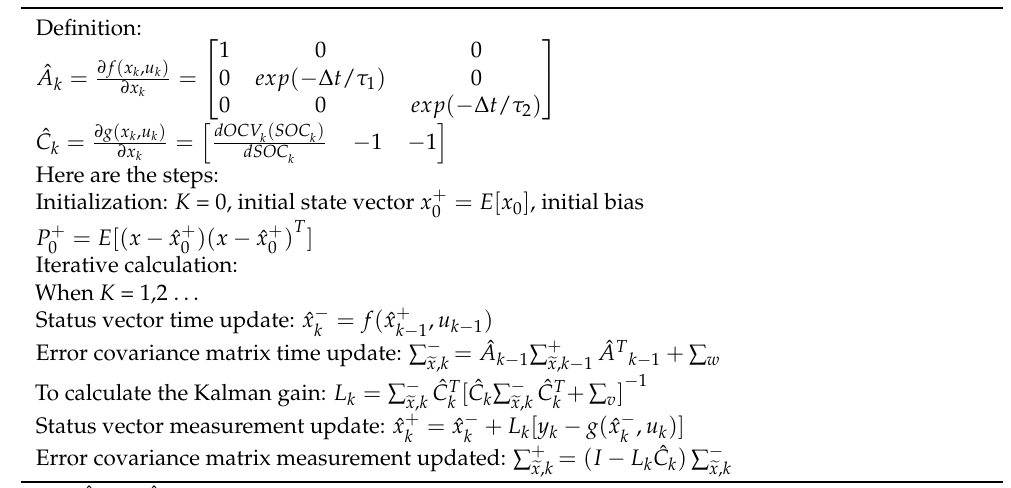
Table 1. Iteration equations of the EKF